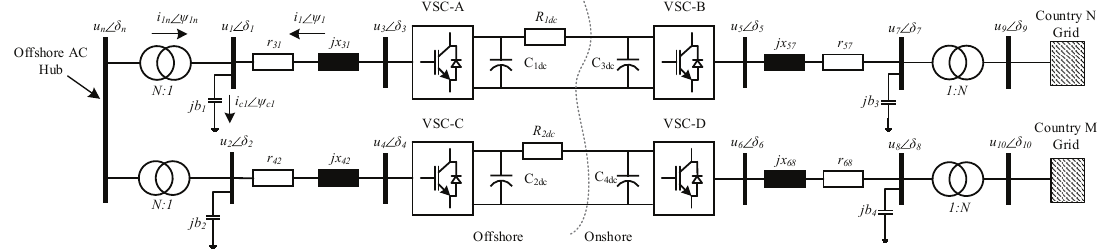
Figure 4. Configuration of VSC-HVDC transmission system to interconnect the offshore AC hub with the